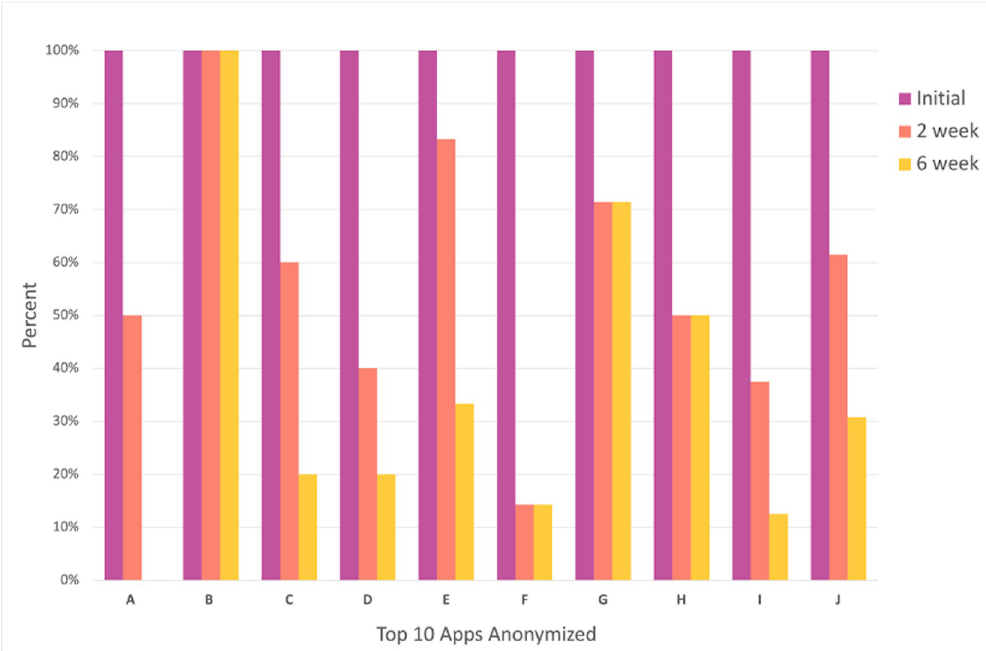
Fig 3. Engagement rates of participants using the top 10 selected